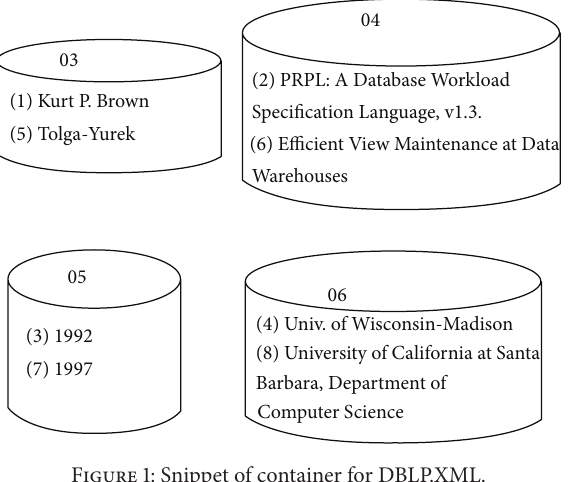
Figure 1: Snippet of container for DBLP.XML.